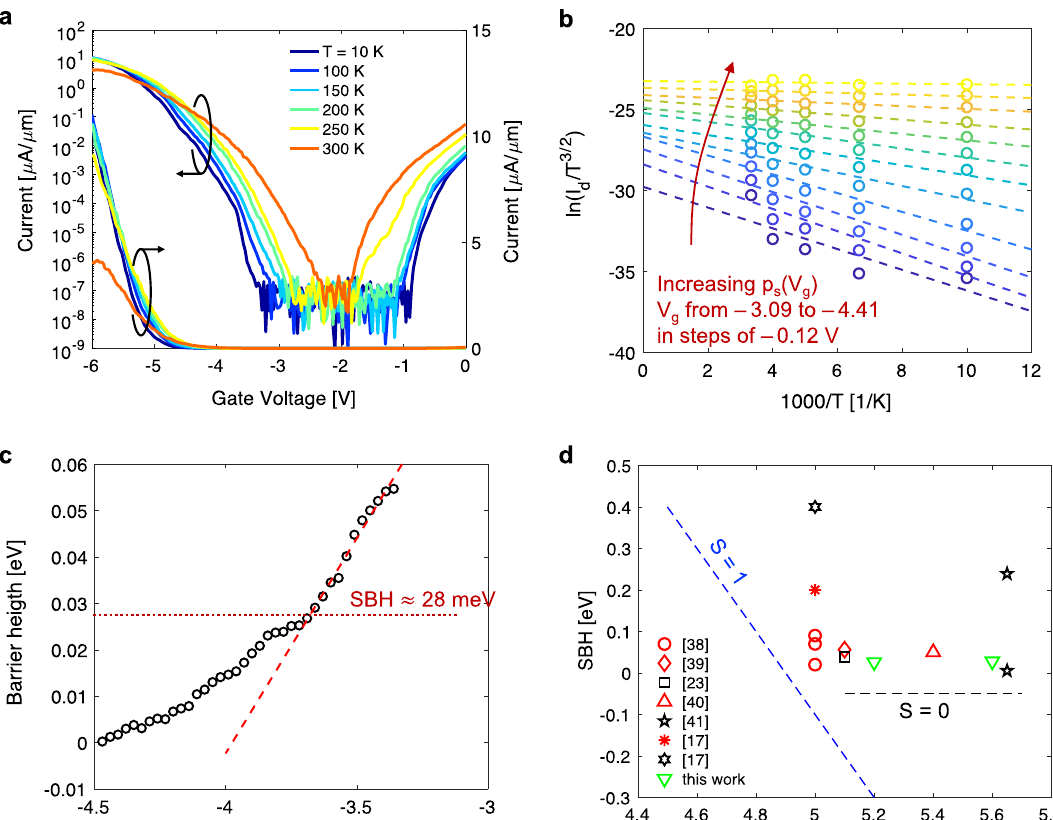
Figure 4. ( a ) I d –V g characteristics at different temperatures ranging from 300 K down to 10 K for WSe 2 PMOS FET with L = 400 nm, and for V ds = –1 V. Current (normalized to channel width) is plotted in linear (right axis) and logarithmic scale (left axis). ( b ) Arrhenius plot of thermionic emission current in 2D semiconductor obtained for different values of V g (from – 3.09 to – 4.41 V) corresponding to different values of sheet carrier density, p s . The slope (dashed lines) can be used to extract barrier height. ( c ) Extractions of barrier height plotted as a function of gate bias, the dashed lines indicate the flat-band voltage for which a deviation